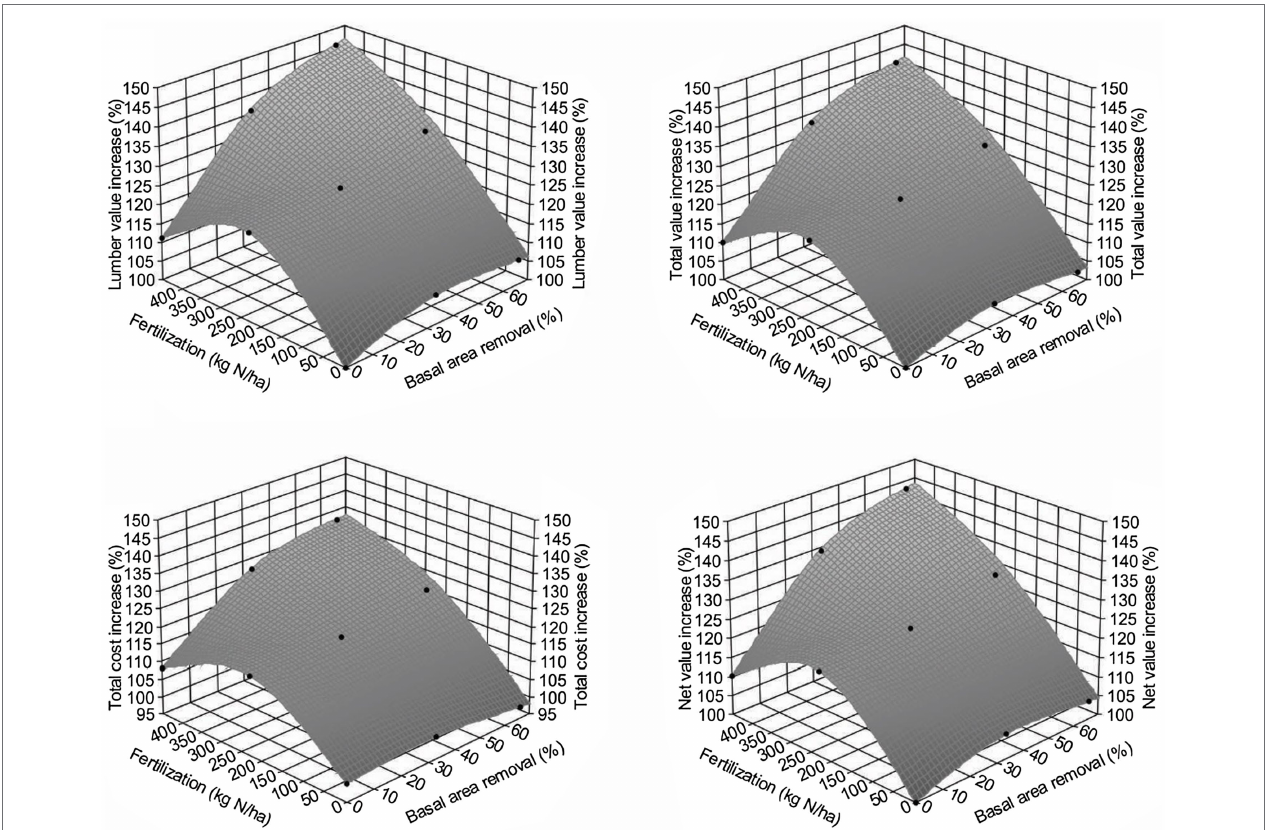
FIGURE 8 | Increase of lumber value recovery (upper left), total value recovery (upper right), total operational cost (lower left), and net value recovery (lower right) for Douglas-fir ( Pseudotsuga menziesii Mirbel) trees, 40 years after different treatment combinations relative to the untreated sites at the Shawnigan Lake trial in British Columbia,